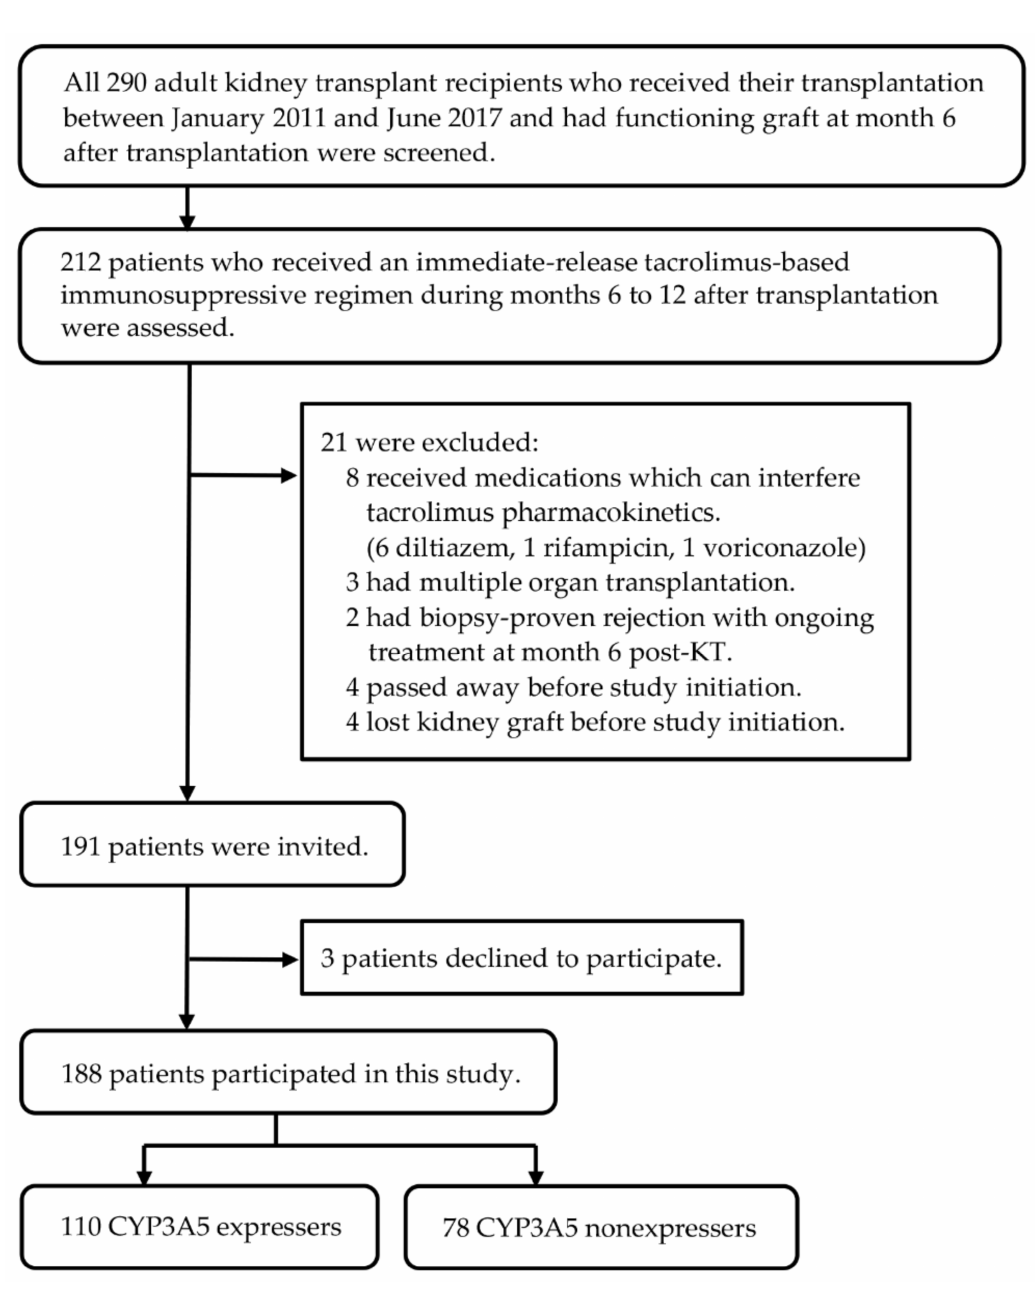
Figure 1. Flow diagram of the inclusion and exclusion process. The median (IQR) of IPVcv was 15.4% (10.2%, 23.9%) and IPVcv of ≥ 30% was de- termined in 19 of 188 (10.1%) KTRs, while the median (IQR) of IPVmad was 11.5% (7.6%, 17.9%) and IPVmad of ≥ 30% was identified in 10 of 188 (5.3%) KTRs. A sign test indicated that IPVcv was significantly higher than IPVmad ( Z = 13.6, p < 0.001, r = 0.995) although a very strong positive correlation between IPVcv and IPVmad was observed (Spearman’s correlation coefficient, r s = 0.997; 95% CI: 0.997 to 0.998; p < 0.001), reflecting a perfect monotonic relationship (Figure 2). The overall medians (IQR) of tacrolimus C0/D were 1.38 (0.95, 2.07), 1.37 (1.02, 2.06), and 1.40 (1.00, 2.32) ng/mL per mg/day at months 6, 9, and 12,